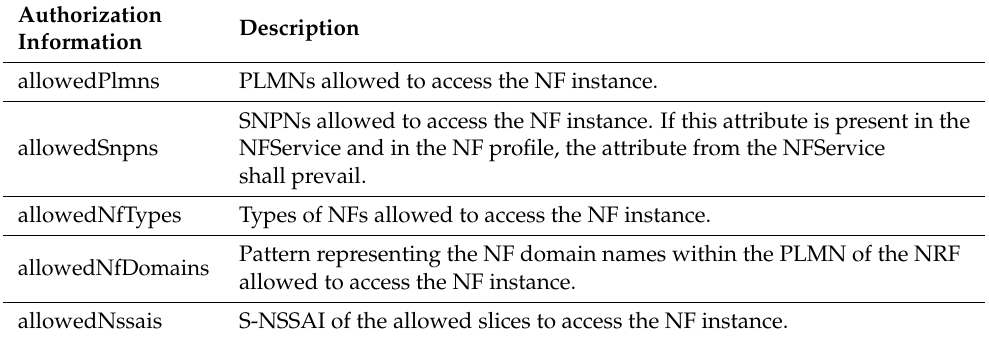
Table 1. Authorization information for Isolation